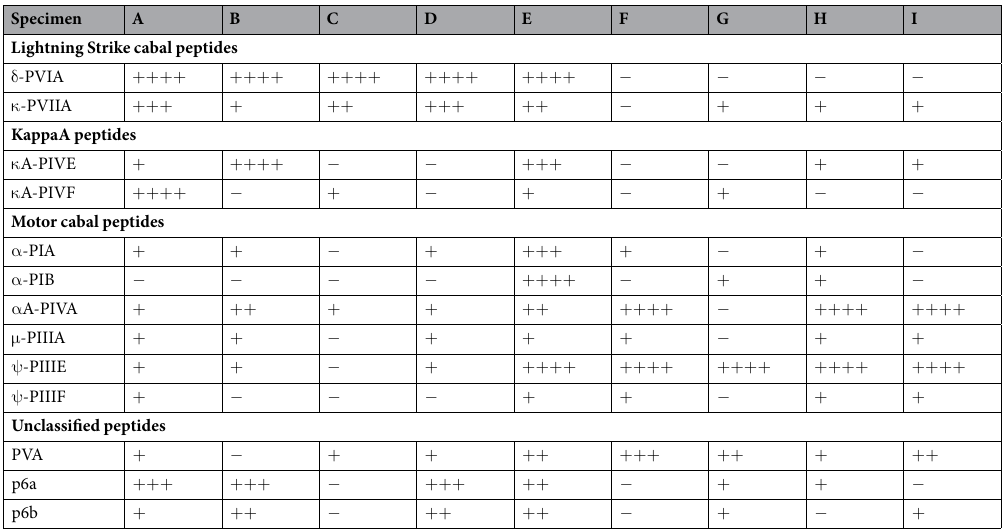
Table 1. Relative expression levels of the previously identified peptides in the predatory injected venom of C. purpurascens across nine specimens detected in ESI-triple-TOF-MS * . * ++++ Relative intensity more than 50, +++ relative intensity between 50 and 10, ++ relative intensity between 10 and 1, + relative intensity below 1, – not